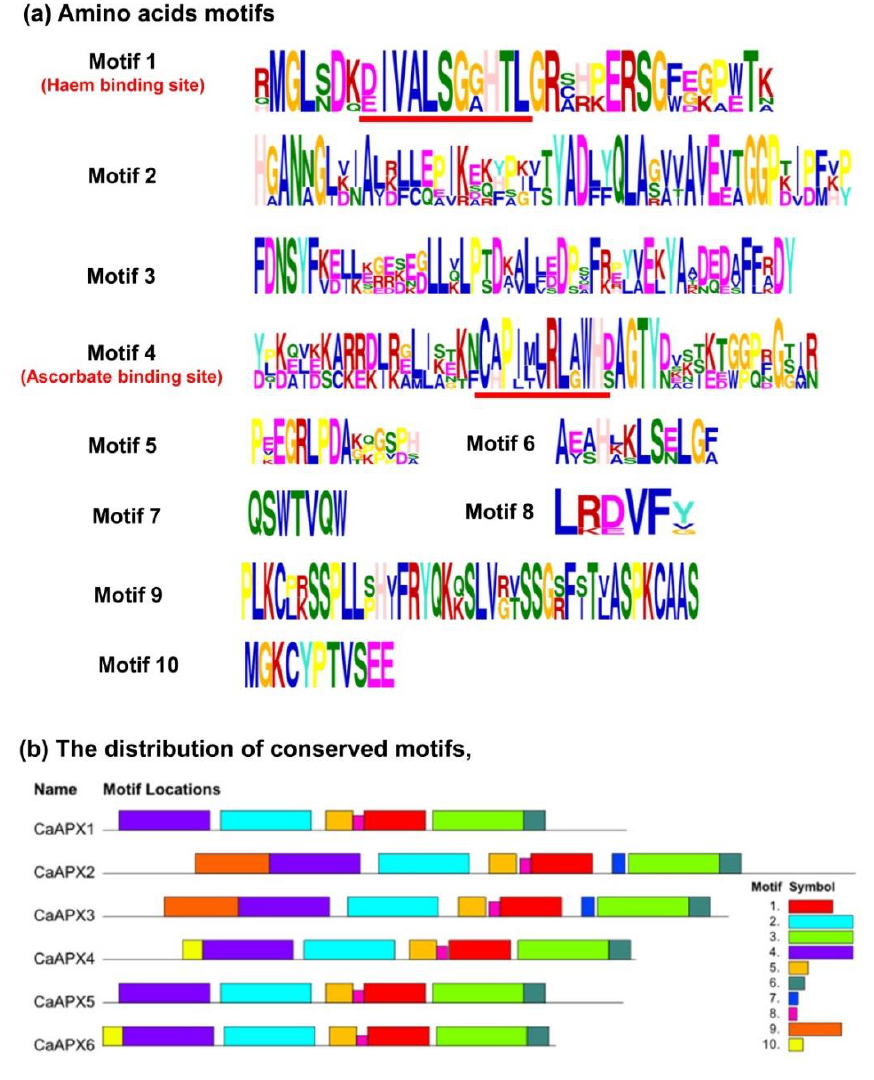
Figure 1. Identification and position of consensus amino acid motifs for sweet pepper APX isozymes. ( a ) Ten amino acid motifs with various widths were identified including the haem and ascor- bate binding sites, motifs 1 and 4, respectively. The height of each amino acid symbol is proportional to the degree of conservation in the consensus sequences depicted in the ten motifs. ( b ) The distri- bution of conserved motifs, numbers 1 – 10, of the six sweet pepper APX proteins, are represented by boxes of different colors. Sequence logos of conserved motifs were created by MEME.